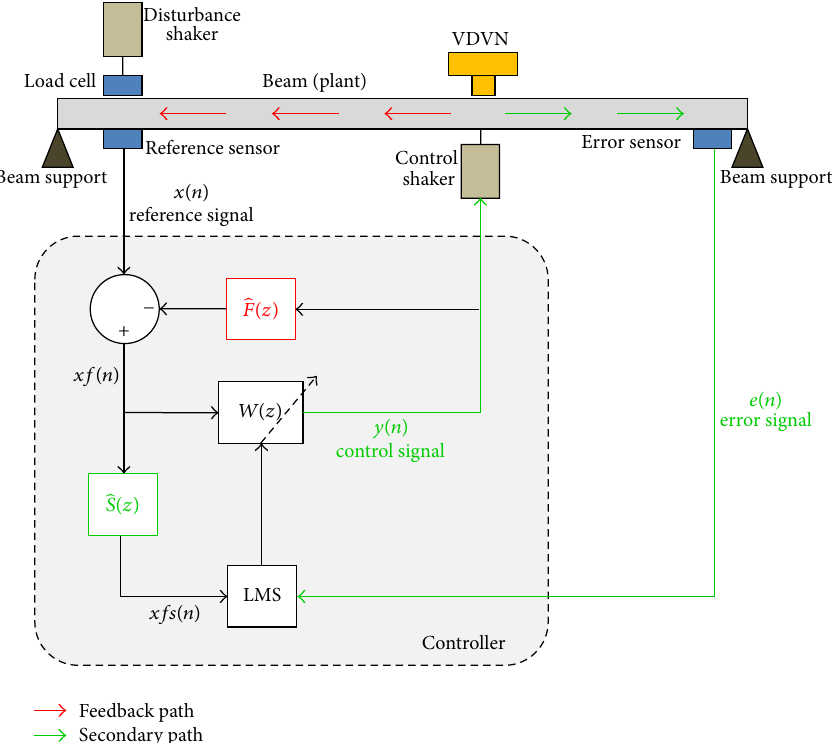
Figure 3: Schema of the employed hybrid vibration control